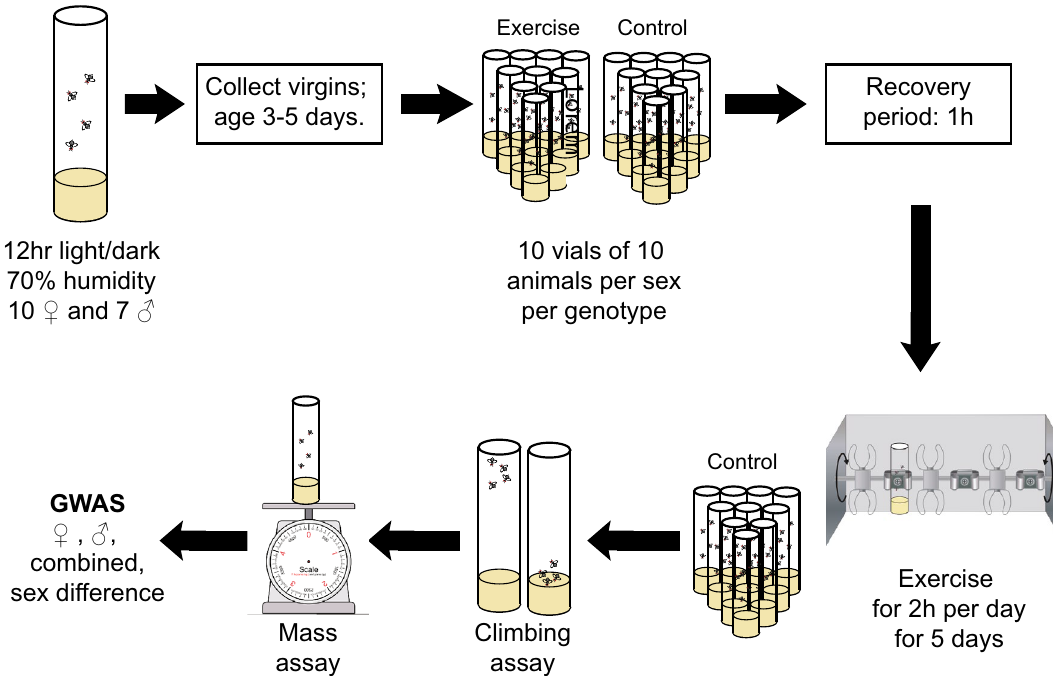
Figure 1. Overview of the experiment. This diagram provides an overview of the study discussed here, illustrating the handling of both control (non-exercised) and treated (exercised)